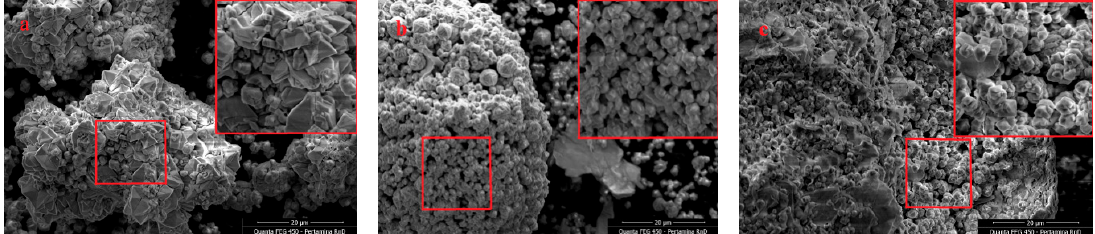
Figure 8. SEM images for ( a ) NaY-LDX, ( b ) NaY-MKSE and ( c ) NaY-SE. The insets show ×2 magnification images.